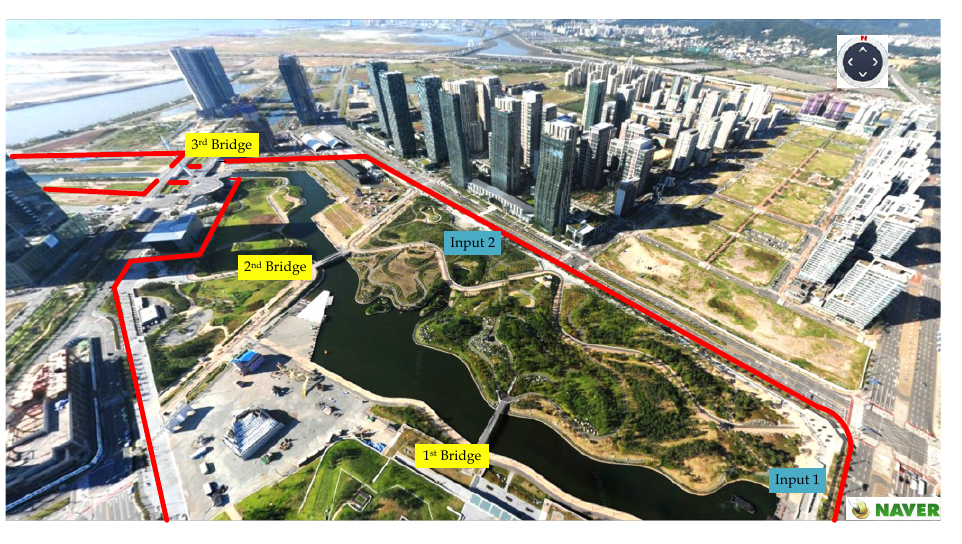
Figure 1. Study site: Central Park, New Songdo City, South Korea, reprinted with permission from [28]. Copyright 2013